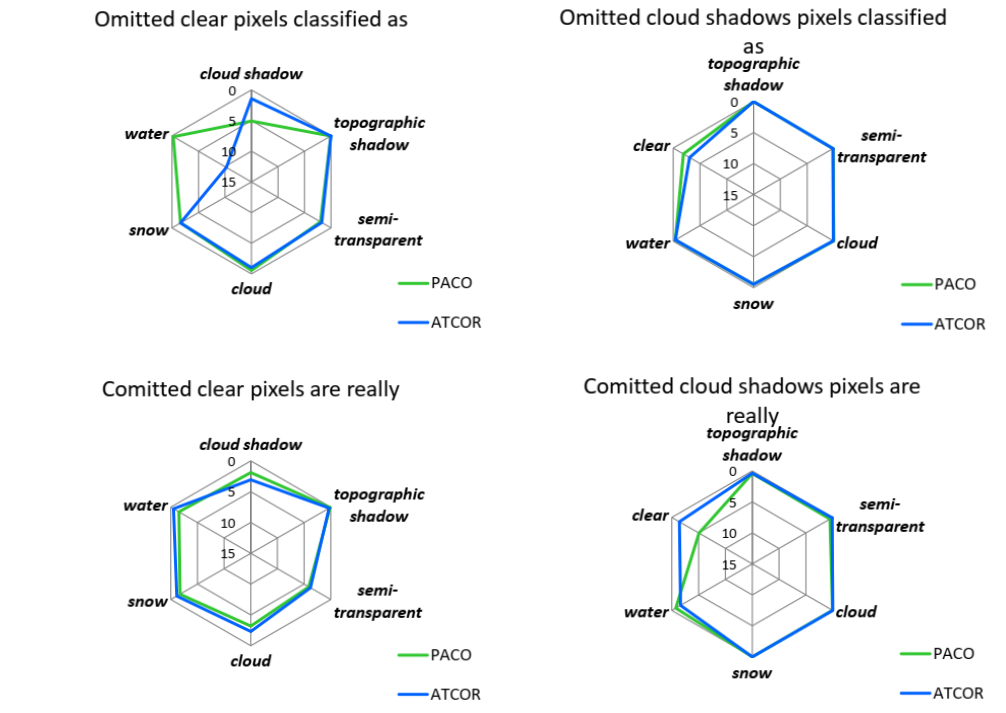
Figure 5. Omission and commission per Class for difference areas for the classes clear and cloud shadows. PACO is represented in the color green and ATCOR in the color